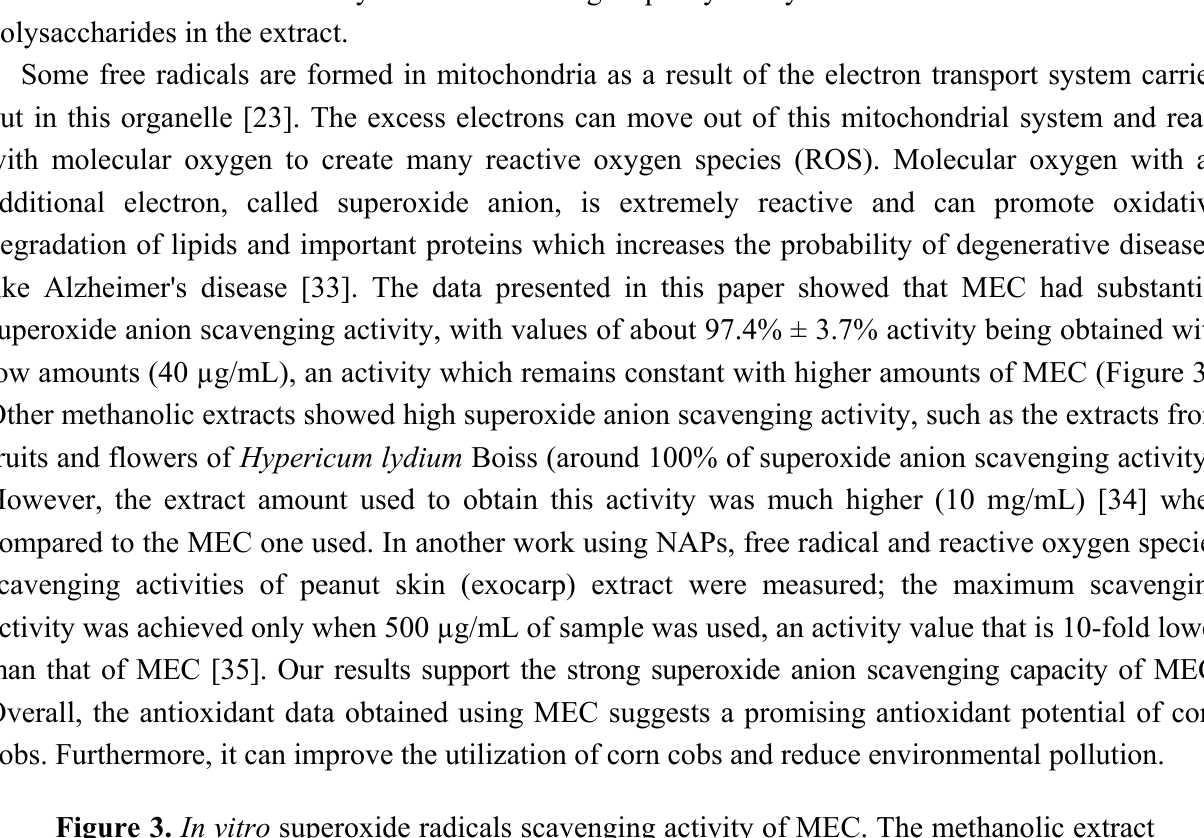
Figure 3. In vitro superoxide radicals scavenging activity of MEC. The methanolic extract reaches maximum activity with 40 µg/mL of sample. Sample concentrations used were 0; 2.5; 5.0; 10; 20; 40; 50 µg/mL. Letters a,b,c,d,e Indicate significantly differences between different concentrations of the same sample. Student-Newman-Keuls test ( p <